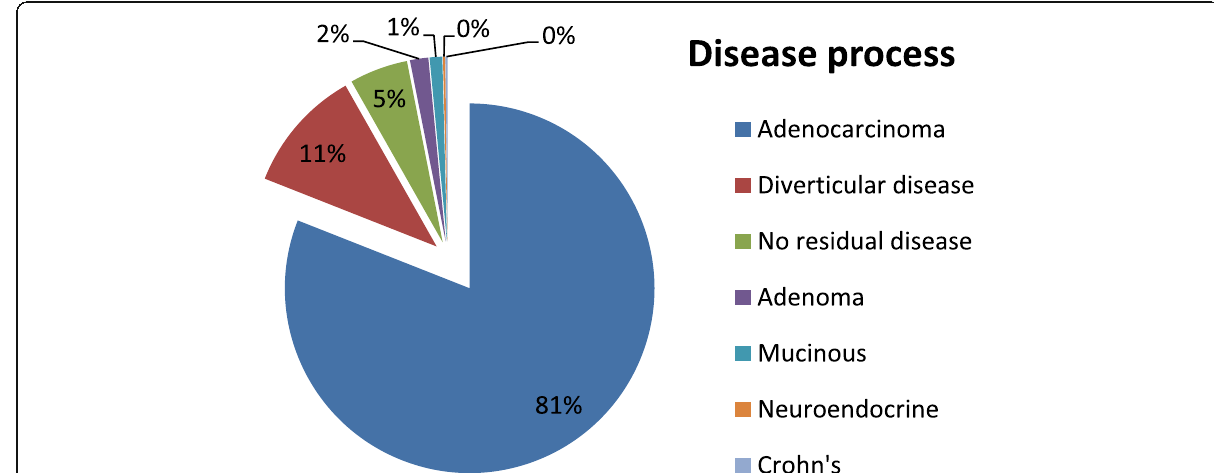
Fig. 2 Graph depicting disease processes found on pathological examination